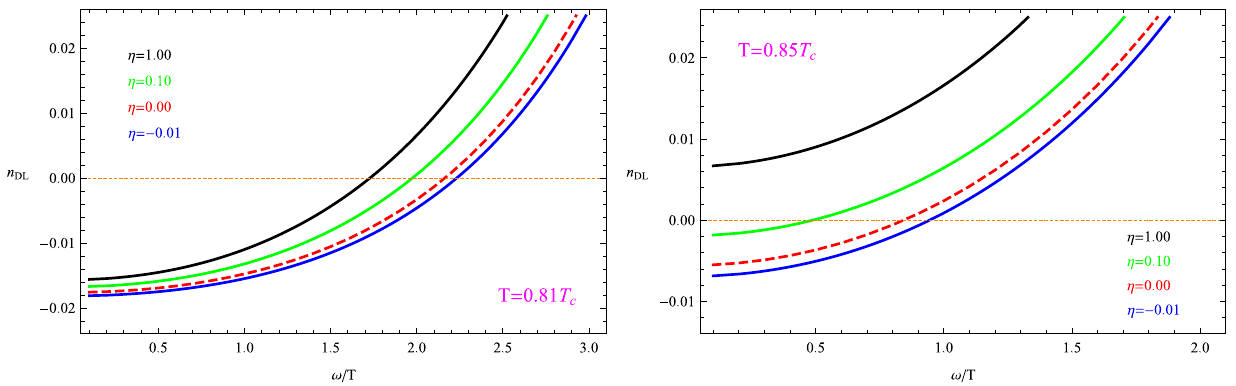
Fig. 10 Depine–Lakhtakia index n DL as a function of ω/ T with the fixed temperatures T = 0 . 81 T c (left) and T = 0 . 85 T c (right) for dif- ferent values of the coupling parameter, i.e., η = − 0 . 01 (blue), 0 . 00